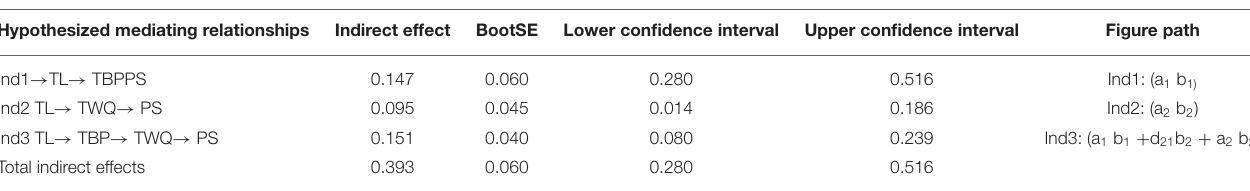
TABLE 5 | Indirect effects. Hypothesized mediating relationships Indirect effect BootSE Lower confidence interval Upper confidence interval Figure